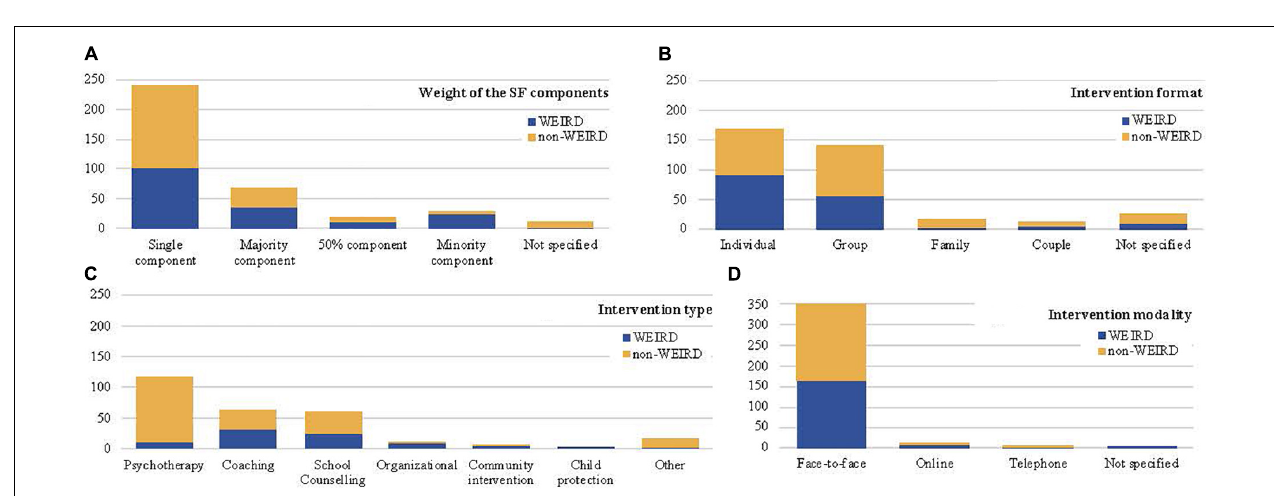
FIGURE 4 | Number of papers and sample size with different types of participants in WEIRD and non-WEIRD studies.